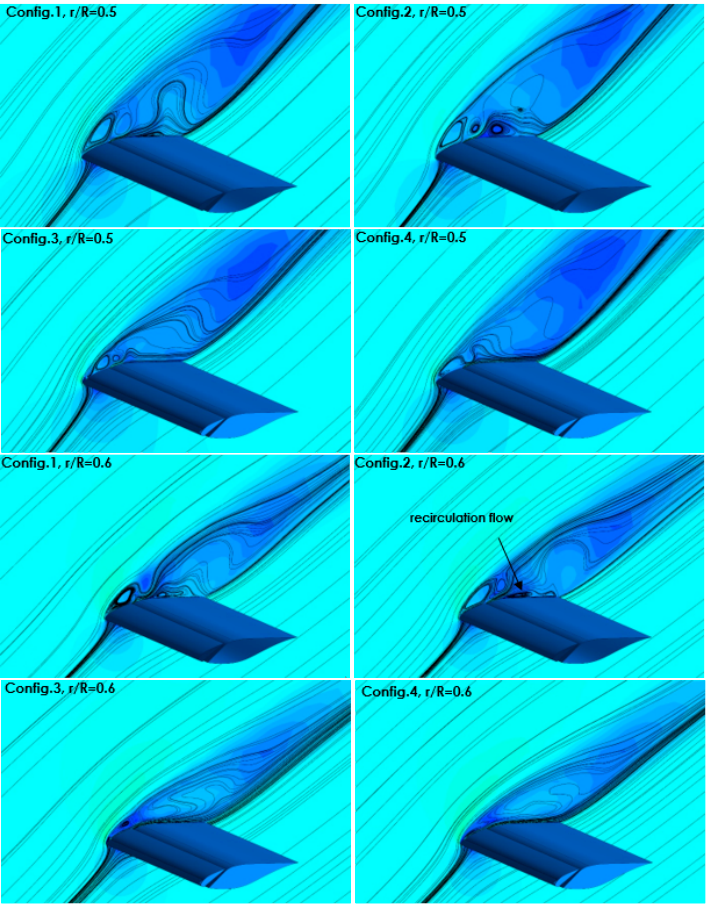
Figure 15. Streamlines and velocity distributions for configurations 1 to 4 compared to baseline at r/R = 0.5 and r/R = 0.6 for wind speed U ∞ = 19 m s − 1 .